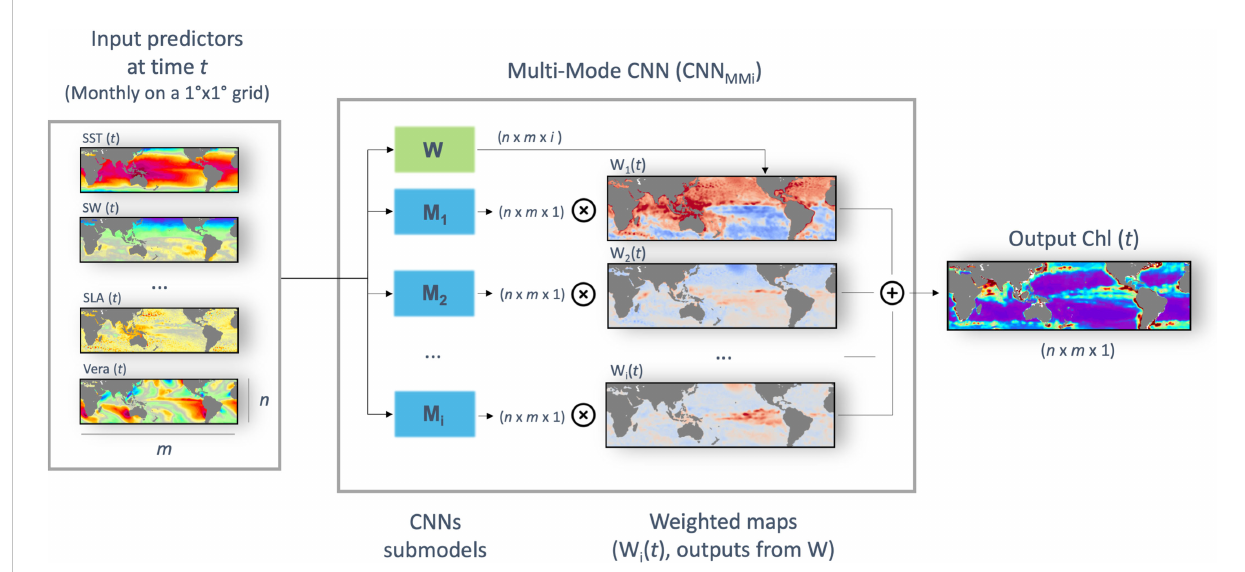
FIGURE 1 Diagram of the CNN MMi architecture. For a given set of input 2D predictors, each of size n x m , i outputs of size n x m x 1 are computed from the i CNN submodels (M i ). Those are spatially weighted according to the i dynamic probability maps outputted at each time t from the W spatial attention module, and summed to obtain the output Chl 2D fi